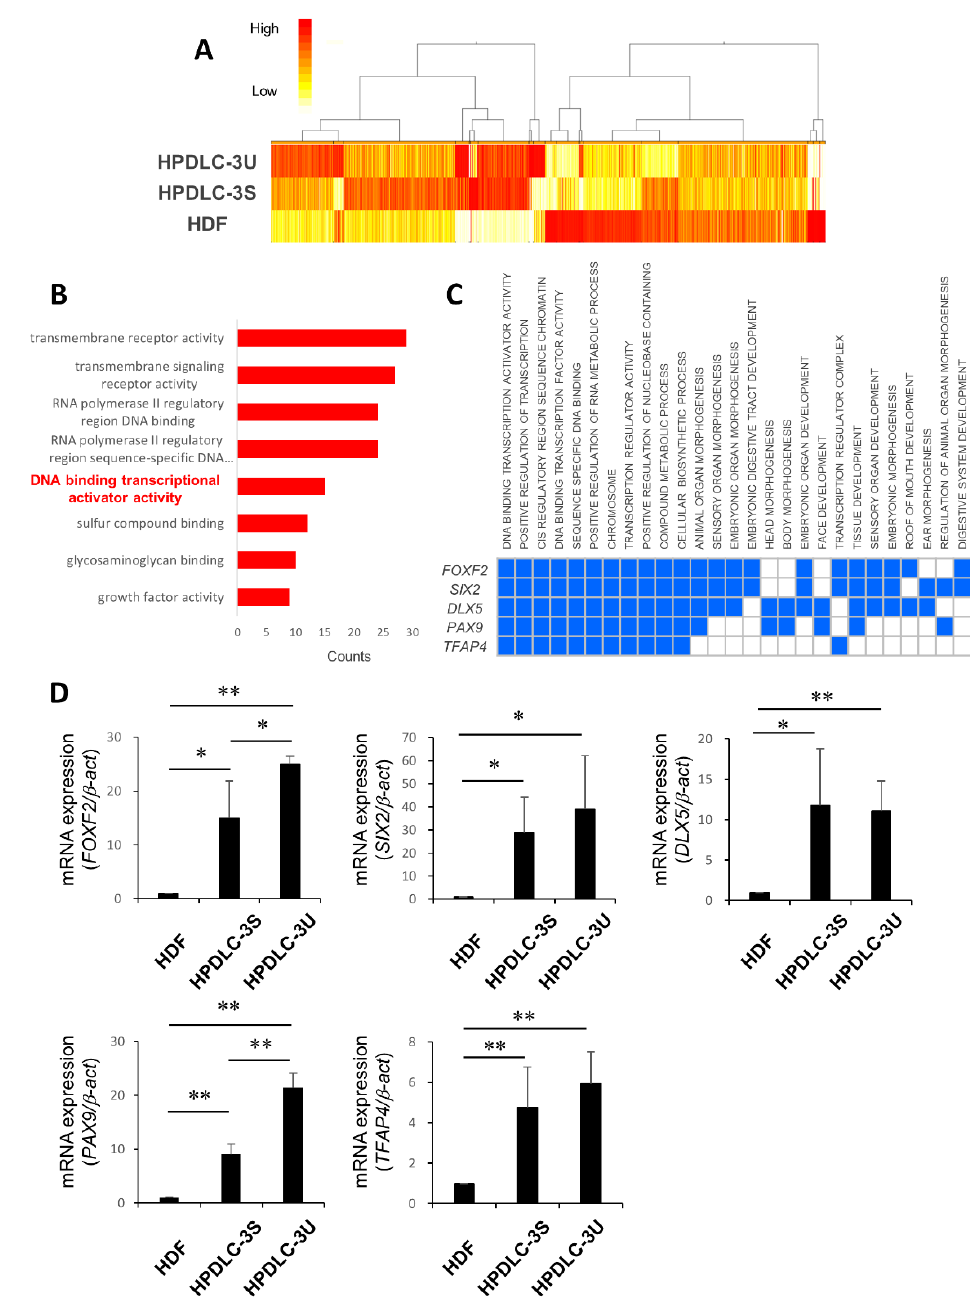
Figure 2. Identification of transcription factor PAX9 responsible for the induction of iNCs to iPDLSCs. ( A ) Heat map and clustering based on hierarchy for gene expression data from CAGE datasets in HDF, HPDLC-3S, and HPDLC-3U. Upregulated genes are represented in red and downregulated genes are represented in yellow. ( B ) GO analysis by BWA software based on upregulated genes in HPDLC-3S compared with HDF in the molecular function group. Data portray the top eight significant terms according to enrichment factor. The term “DNA binding transcriptional activator activity” included 15 genes. ( C ) GO analysis by GSEA software for FOXF2 , SIX2 , DLX5 , PAX9 , and TFAP4 . Blue color means the GO term in which each gene is involved. ( D ) Quantitative real time RT-PCR analysis of FOXF2 , SIX2 , DLX5 , PAX9 , and TFAP4 in HDF, HPDLC-3S, and HPDLC-3U. β -act was used as an internal standard. Data are portrayed as the mean ± standard deviation ( n = 4). * p < 0.05, ** p < 0.01. CAGE, cap analysis of gene expression; GO, gene ontology; GSEA, gene set enrichment analysis.